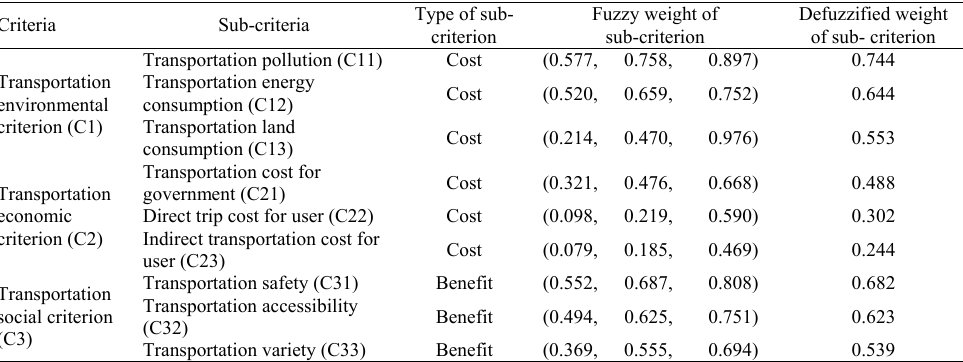
Table 6: Sustainable transportation criteria, their fuzzy weights, and defuzzified weights